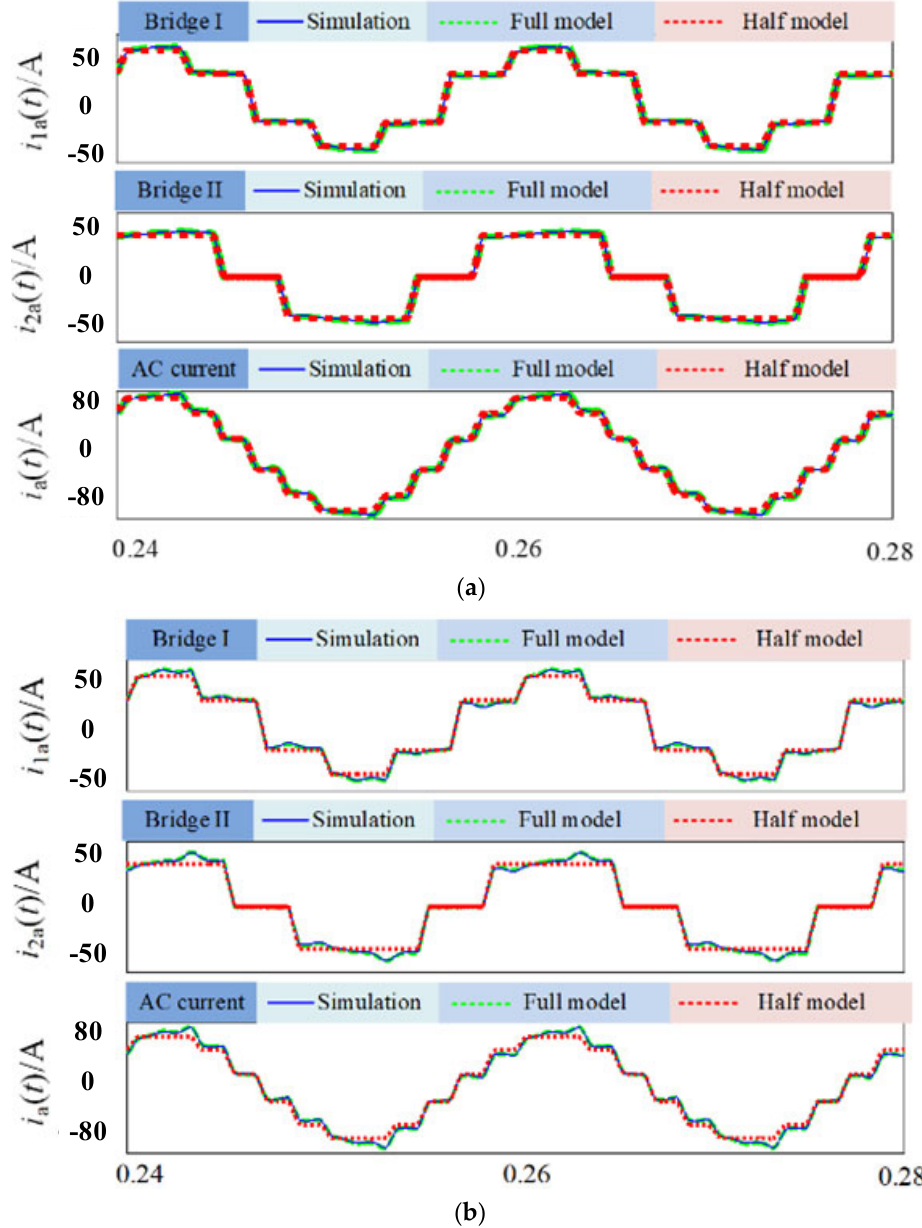
Figure 5. Time-domain current comparison of rectifier under different conditions. ( a ) Case 1; ( b ) Case 2. The amplitude and phase of the harmonic current of the 12-pulse rectifier are shown in Figure 6. The current main contains 12 k ± 1th harmonic current. With the influence of negative sequence, 3rd, 9th, 15th . . . , the harmonic current is observed in the simulation and complete model